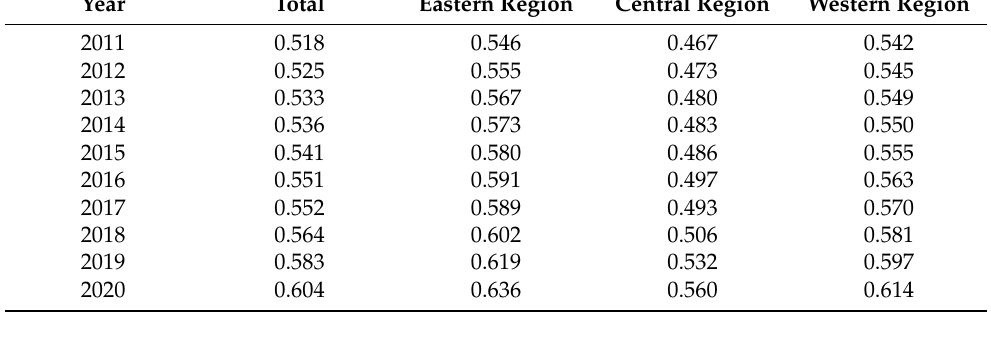
Table 4. Average development level of green agriculture in China from 2011 to 2020. Table 3. Average development level of China’s digital economy from 2011 to 2020.